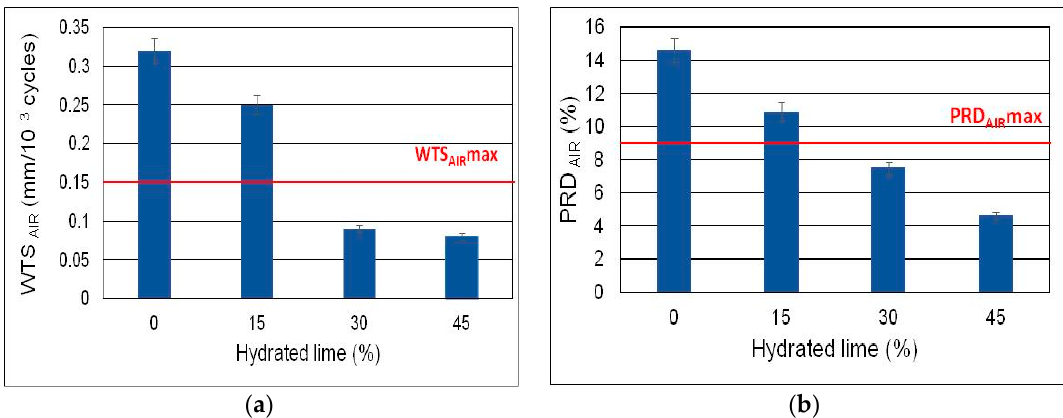
Figure 11. Resistance to permanent deformation of AC 8 S mixture at the recommended 5.9% content of foamed bitumen; ( a ) WTS AIR , ( b ) PRD AIR .